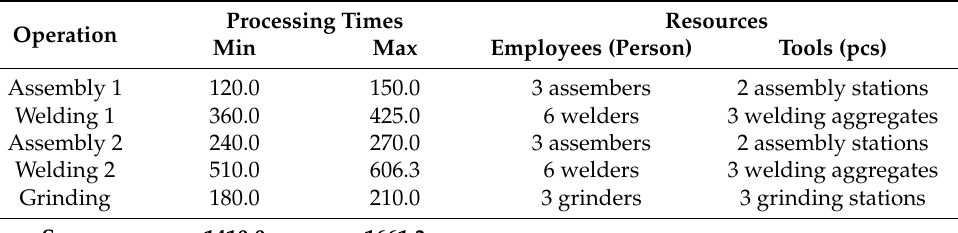
Table 1. Processing times of individual operations of the technological process of producing the scraper conveyor chute.